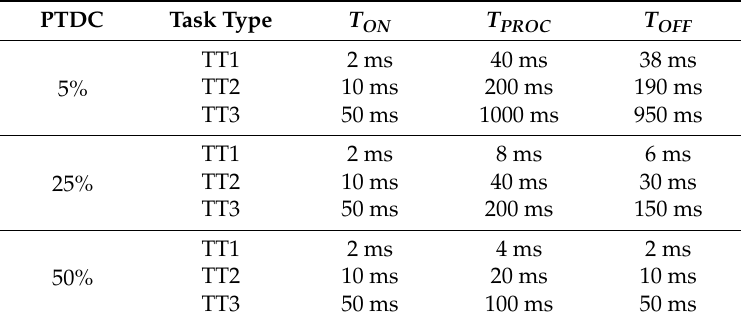
Table 2. Processing task times for different PTDC and task type